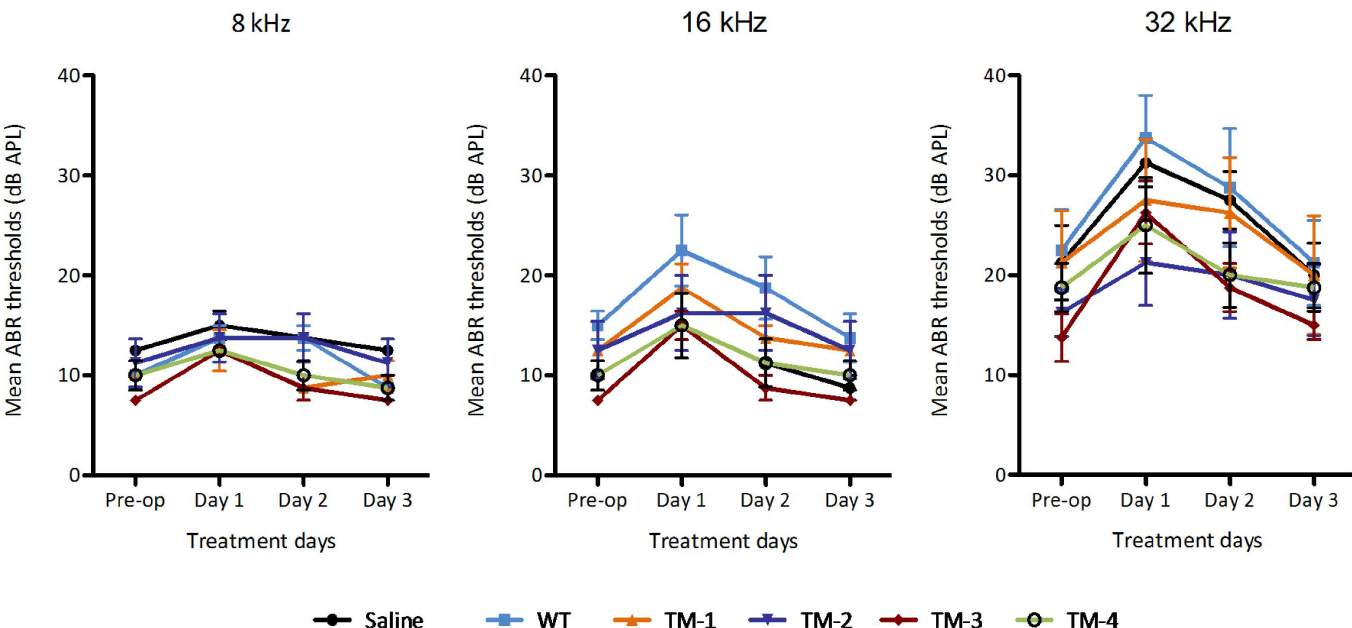
Fig 6. Impact of trans-TM peptide phage on hearing. ABR thresholdsmeasuredin dB SPL (Sound Pressure Level relative to .0002 dynes/cm 2 ) were recordedpre-operatively and daily for four days following10 10 phage particleinjectioninto the ME bulla. Responses were obtained for 8, 16, and 32 kHz pure- tone stimuli. Results indicate that thresholdswere elevated up to 20 dB on postoperative days 1 and 2, recoveredto within +/- 5 dB of baselineby day 3. Results for four TM-transiting phage,WT phageand saline were similar, indicating that the temporary change in threshold is due to fluid, and that no damage to hearingoccurredas a result of TM-transiting phageapplication.Data are means + SEM (n = 8).